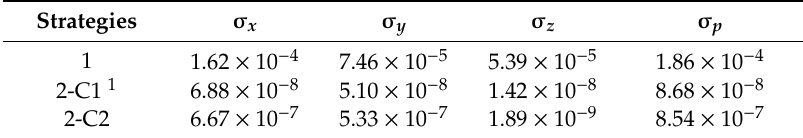
Table 4. Homonymous points accuracy in two